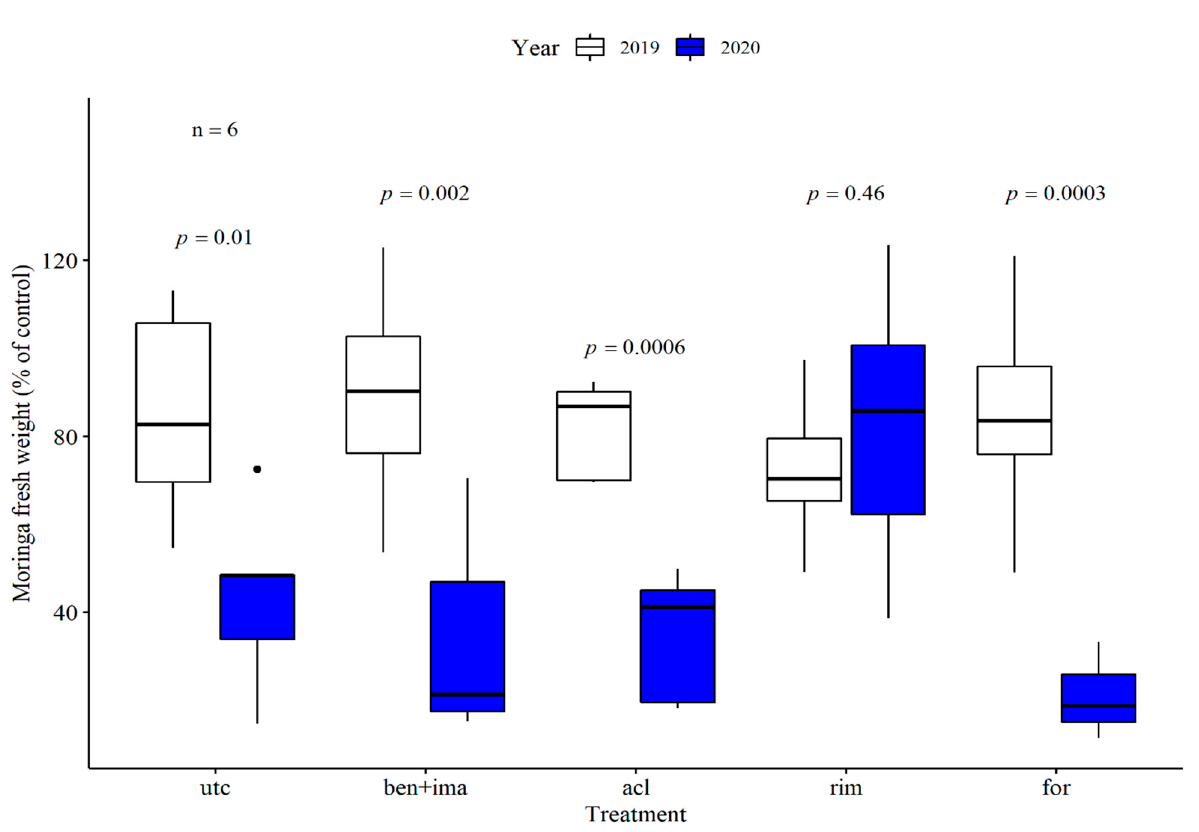
Figure 2. Effect of POST herbicides application on moringa fresh weight. Treatments included: untreated control (utc), bentazon + imazamox (ben + ima), aclonifen (acl), rimsulfuron (rim), and foramsulfuron (for). Comparisons between years within treatment were assessed using a t-test ( n = 6).